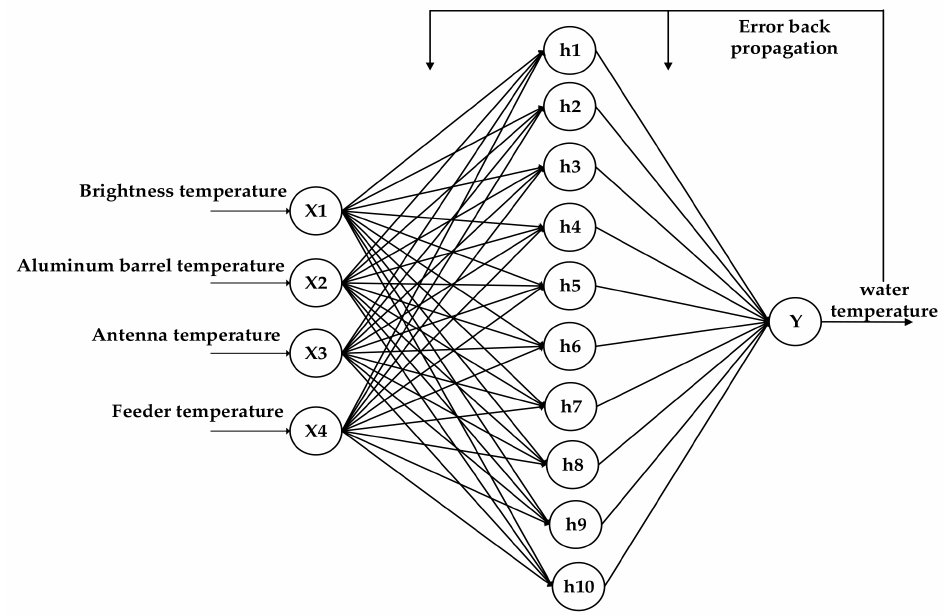
Figure 27. BP neural network model. The three-layer BP neural network is used to train 125 data sets for 10,000 rounds. The input variables of the data set are the brightness temperature of water, the aluminum plate temperature, the antenna temperature and the feeder temperature, and the output variable is the physical temperature of water. Twenty-nine groups of test data are used for verification. The result is shown in Figure